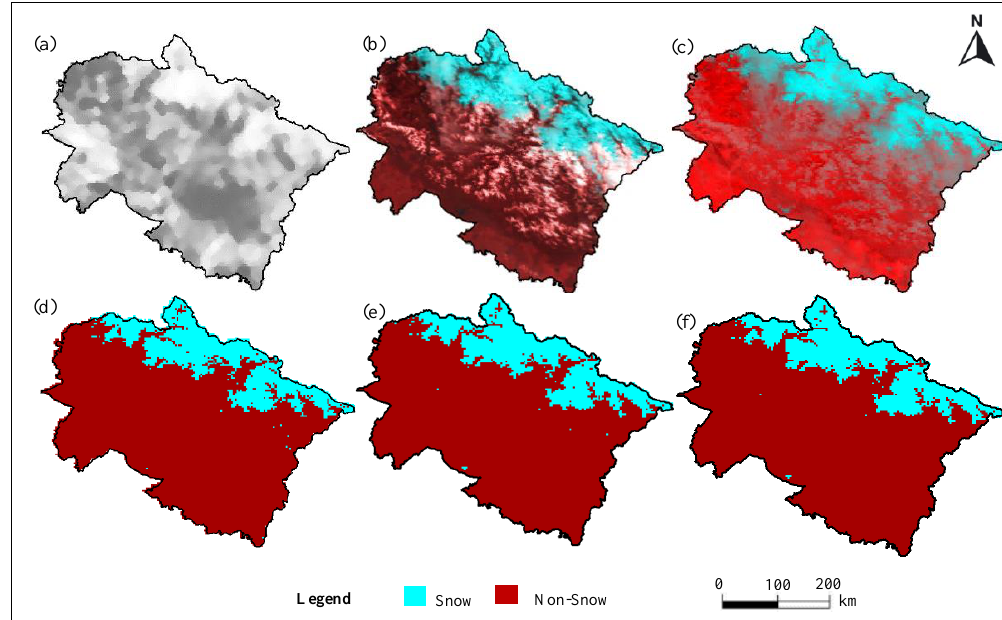
Fig. 3 Representation of (a) SCATSAT-1 image (sigma-nought), (b) MODIS imagery (RGB-611), (c) fused image, (d) Linear Spectral Missing (LSM), (e) Random Forest Classifier (RFC), and (f) Support Vector Machine (SVM).